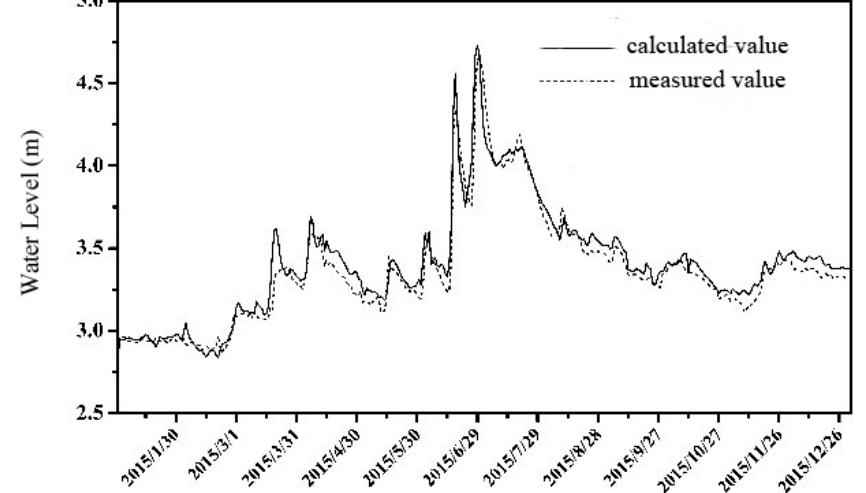
Figure 2. The Verification results of Water Level.